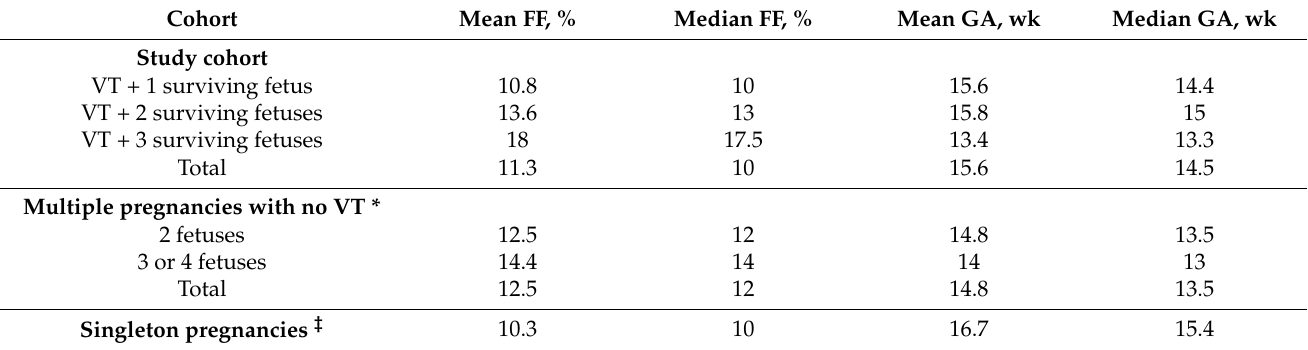
Table 2. Fetal fractions for the study cohort and comparison cohorts.